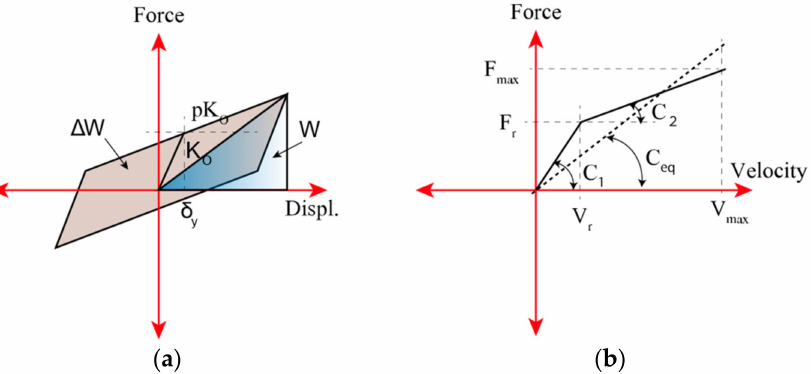
Figure 1. ( a ) The force–displacement relation of the bilinear hysteresis model; ( b ) the force–velocity relation of bilinear-type oil